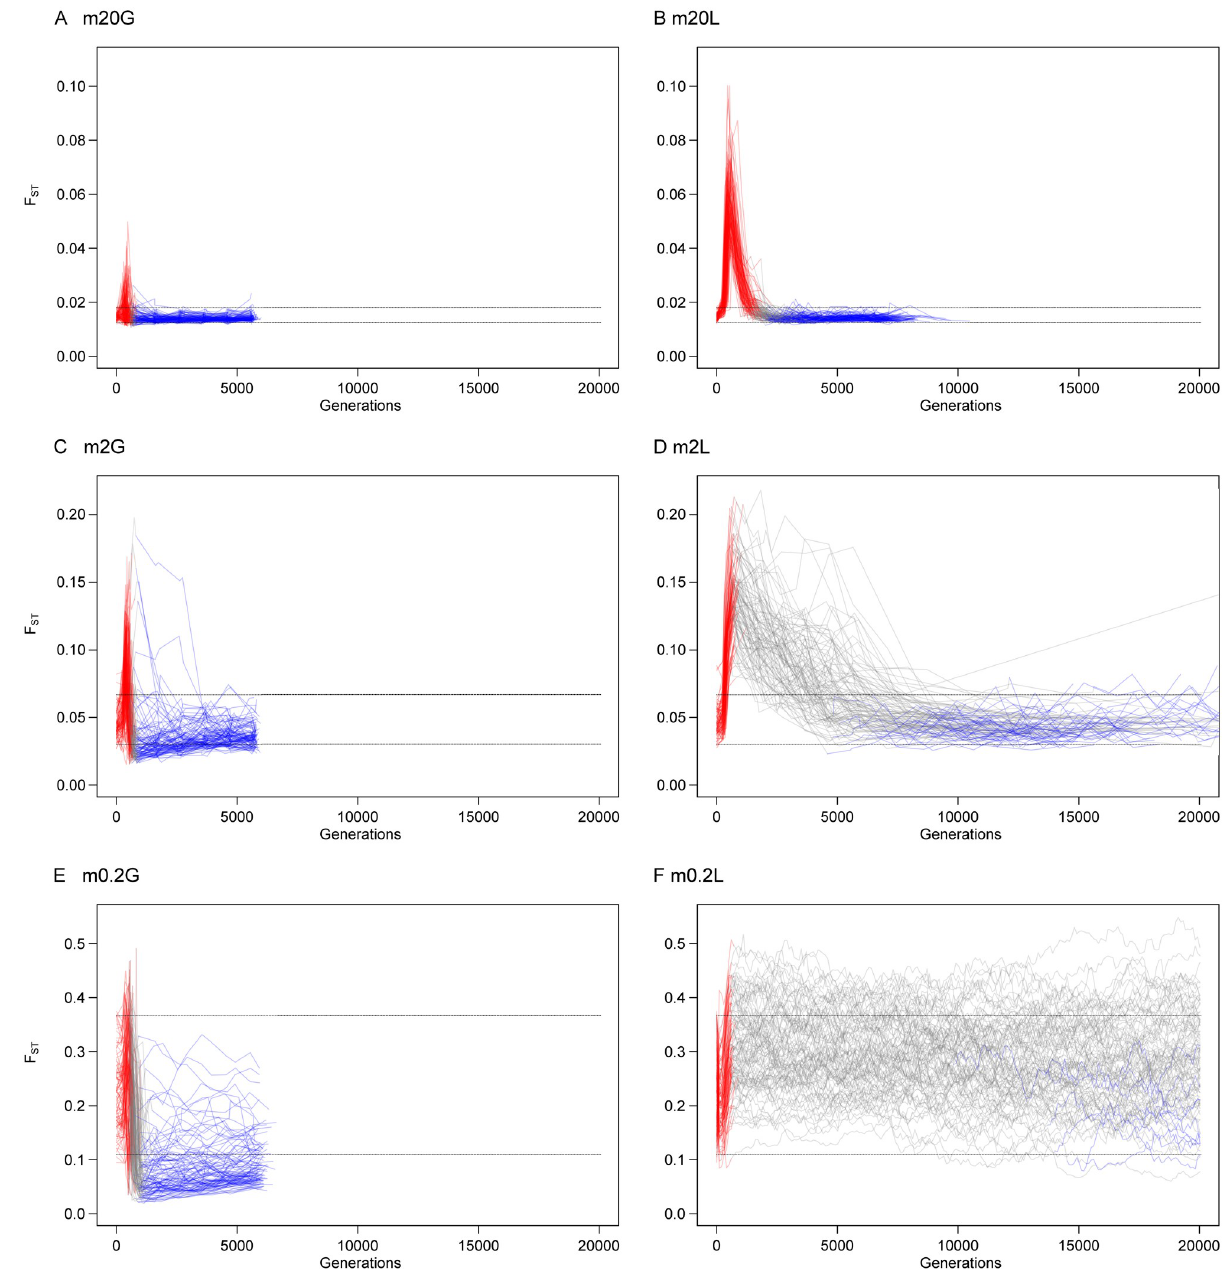
Fig 10. Full-locus simulation: F . The change of between-deme F during a selective sweep and recovery. Red indicates the period before the ST ST adaptive allele reaches 99.5% in d 1 , blue indicates the period after global fixation, and gray for the period in-between. Each line is one replicate population. The scenarios are: A. m 20 G ; B. m 20 L ; C. m 2 G ; D. m 2 L ; E. m 0.2 G ; F. m 0.2 L . For m 0.2 L the time points are fixed number of generations (every 100 generations) instead of based on allele frequency. Horizontal dash lines denote the 95% range of the neutral baseline F